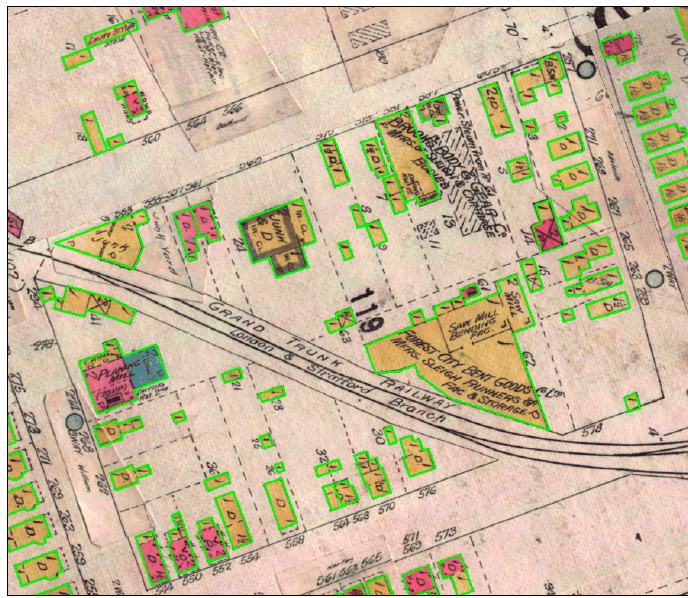
Figure 2. The London Historical Spatial Data Infrastructure’s (HSDI) built environment data incudes over 116,000 manually digitized building footprints covering the period 1888–2016. Each footprint (shown above in green) is linked in the HSDI to detailed attribute information derived from historical fire insurance plans, business directories, and other archival sources. Image by author. The Imag(in)ing London Historical GIS project [22] represents an early implementation of the HSDI concept [18] and this project (hereafter referred to as the London HSDI) forms the basis of the present longitudinal investigation of industrial hazards. The London HSDI consists of two environmental “stages”: the Built Environment (BE) stage and the Social Environment (SE) stage. The BE stage is a GIS-based reconstruction of London’s built environment derived from scanned and georeferenced historical cartography that has been vectorized in GIS and populated with attribute data from the source material including the building’s address, construction materials, number of stories, and occupant. The BE consists primarily of building footprints and road and rail networks (Figure 2). To date the London HSDI contains over 116,000 historical building footprints as well as a representation of modern London’s built infrastructure obtained from the City of London’s municipal GIS. The SE stage populates this virtual historic landscape with historical records of the population that lived in London, with each record geocoded to the person’s place of residence and